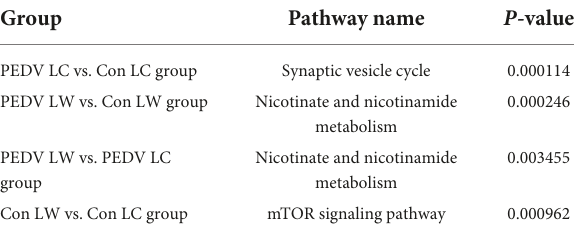
TABLE 8 Significant enrichment pathways for differential metabolites in the